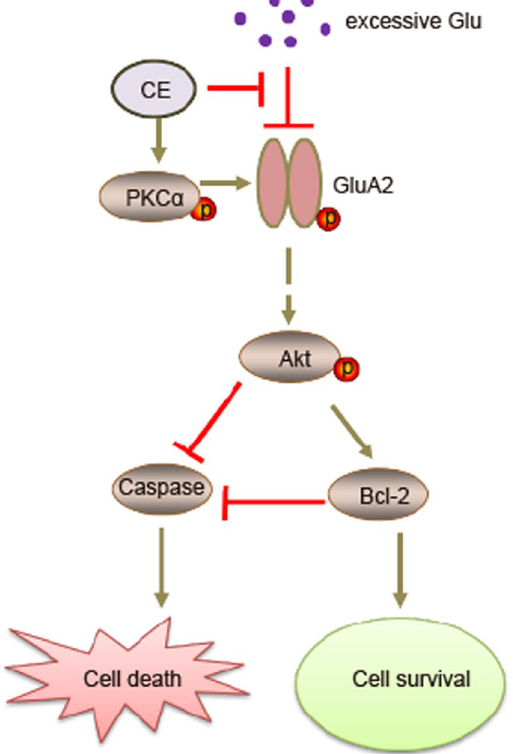
Figure 7. The proposed working model of the neuroprotective effect of CE. Excessive extracellular glutamate overstimulates GluRs and induces excitotoxicity, which is blocked by CE via the PKC-GluA2 axis. CE further regulates the Akt-Bcl-2-Caspase signalling pathway to prevent cell death and promote cell survival, exerting a neuroprotective